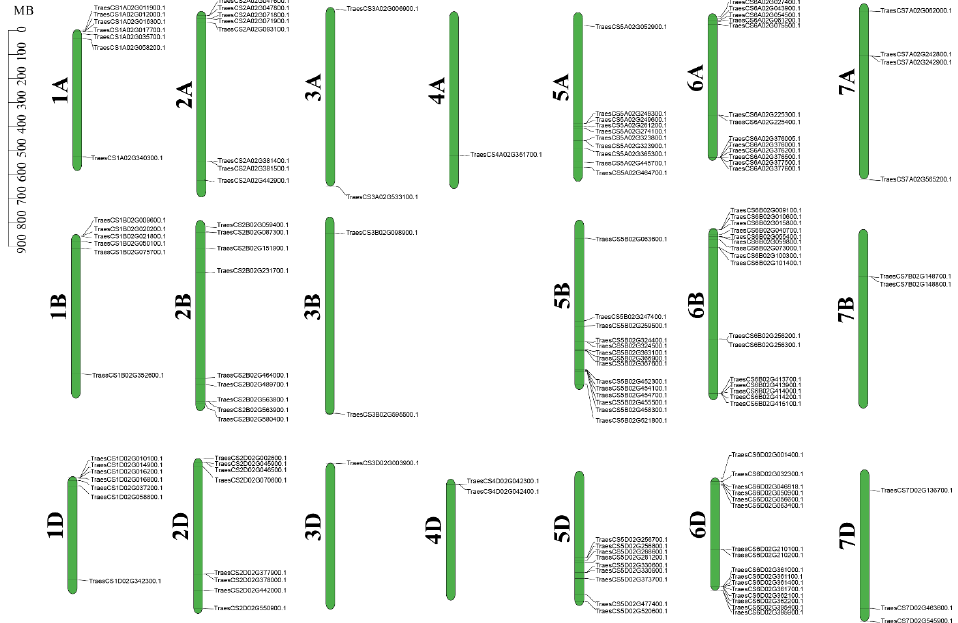
Figure 1. Chromosomal distribution of the typical TaWAK genes in wheat. The 140 TaWAK genes were unevenly distributed on 20 wheat chromosomes. The bar indicates the length of chromosome in megabases